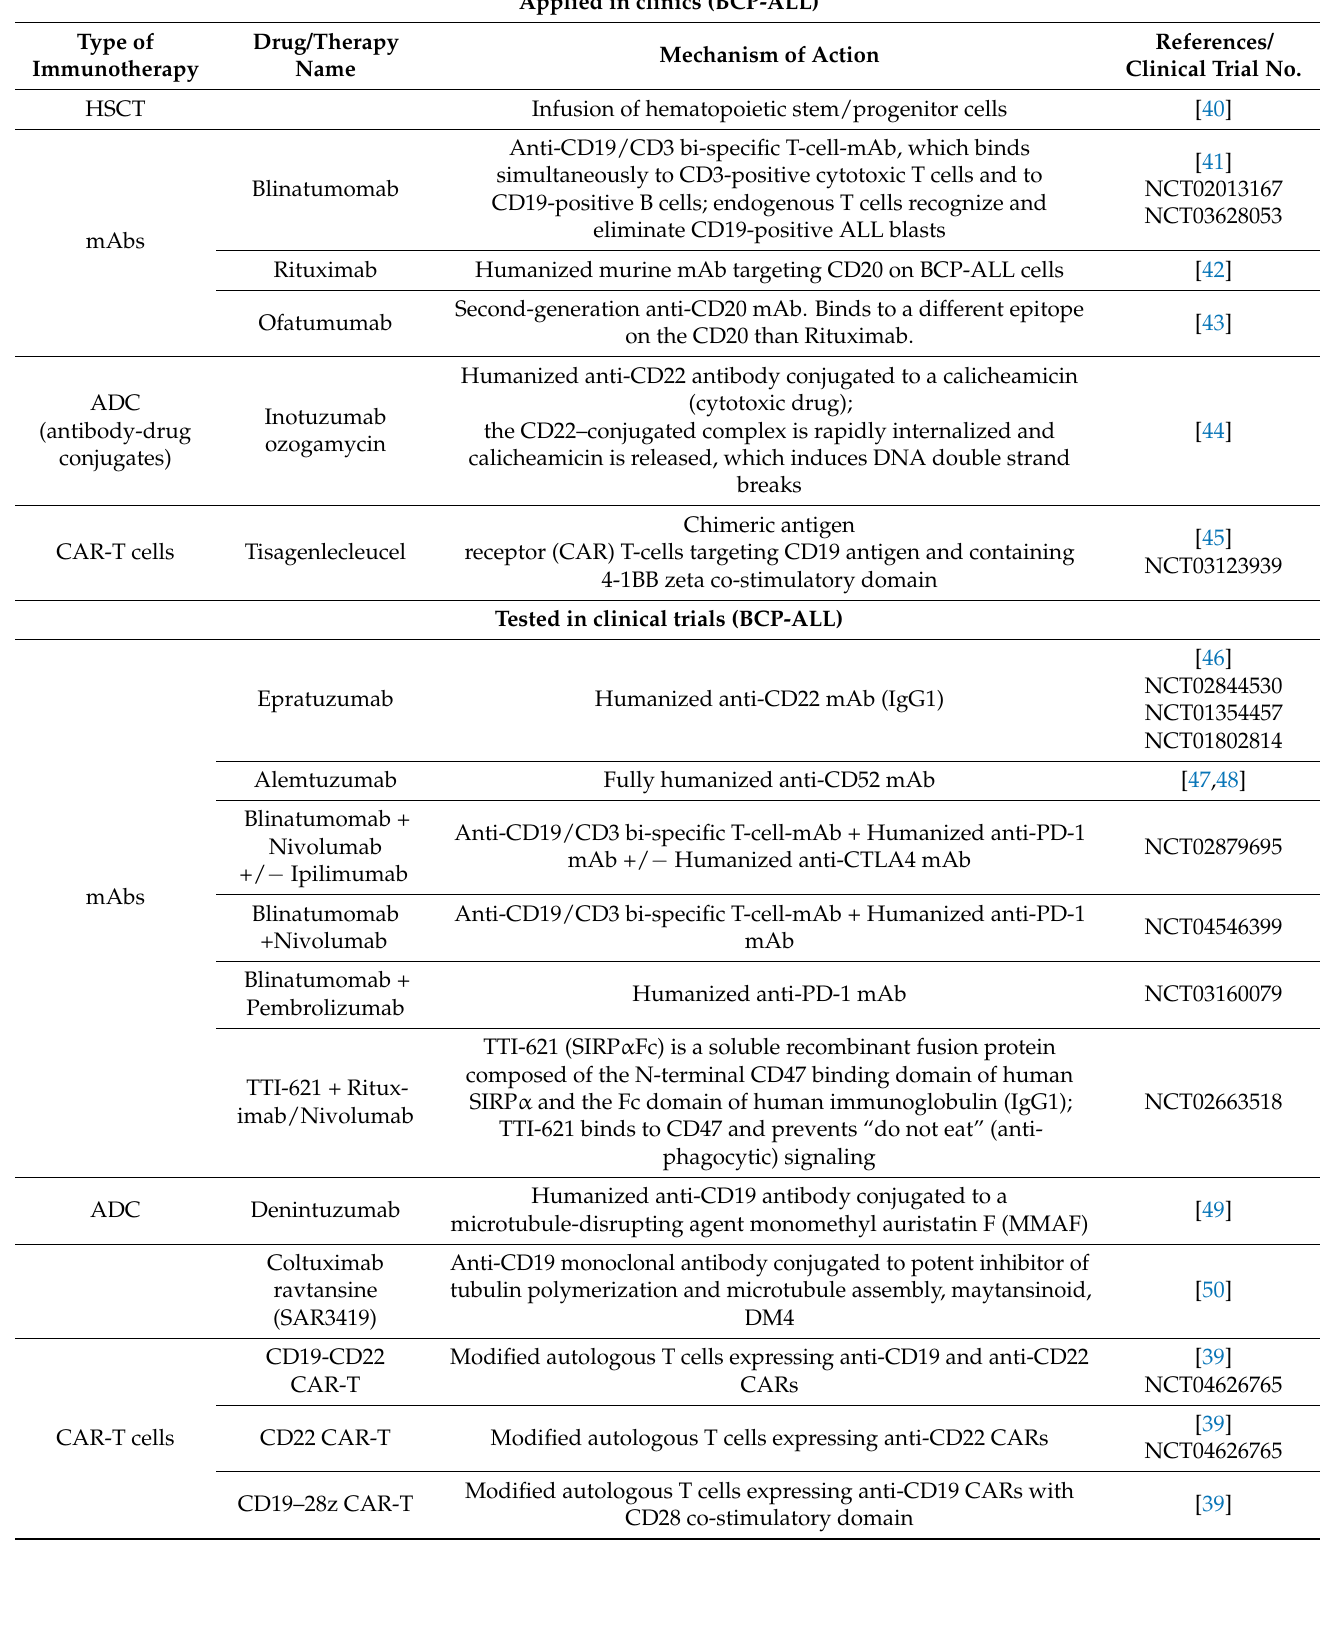
Table 3. Overview of immunotherapy used against acute lymphoblastic leukemia. Applied in clinics